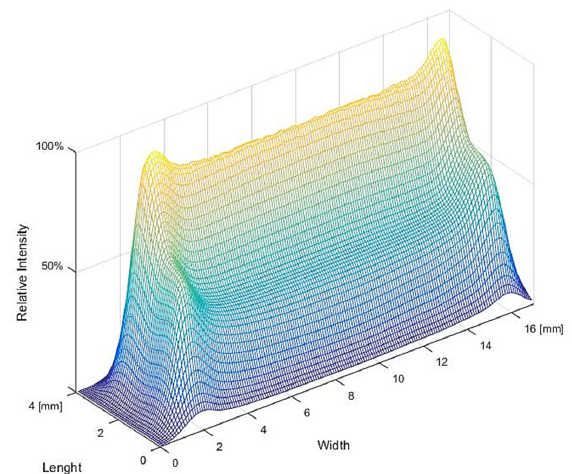
Figure 5. Calculated intensity distribution to generate a top ‐ hat temperature field in 42CrMo4 (ANSI 4140) at 400 mm/min.